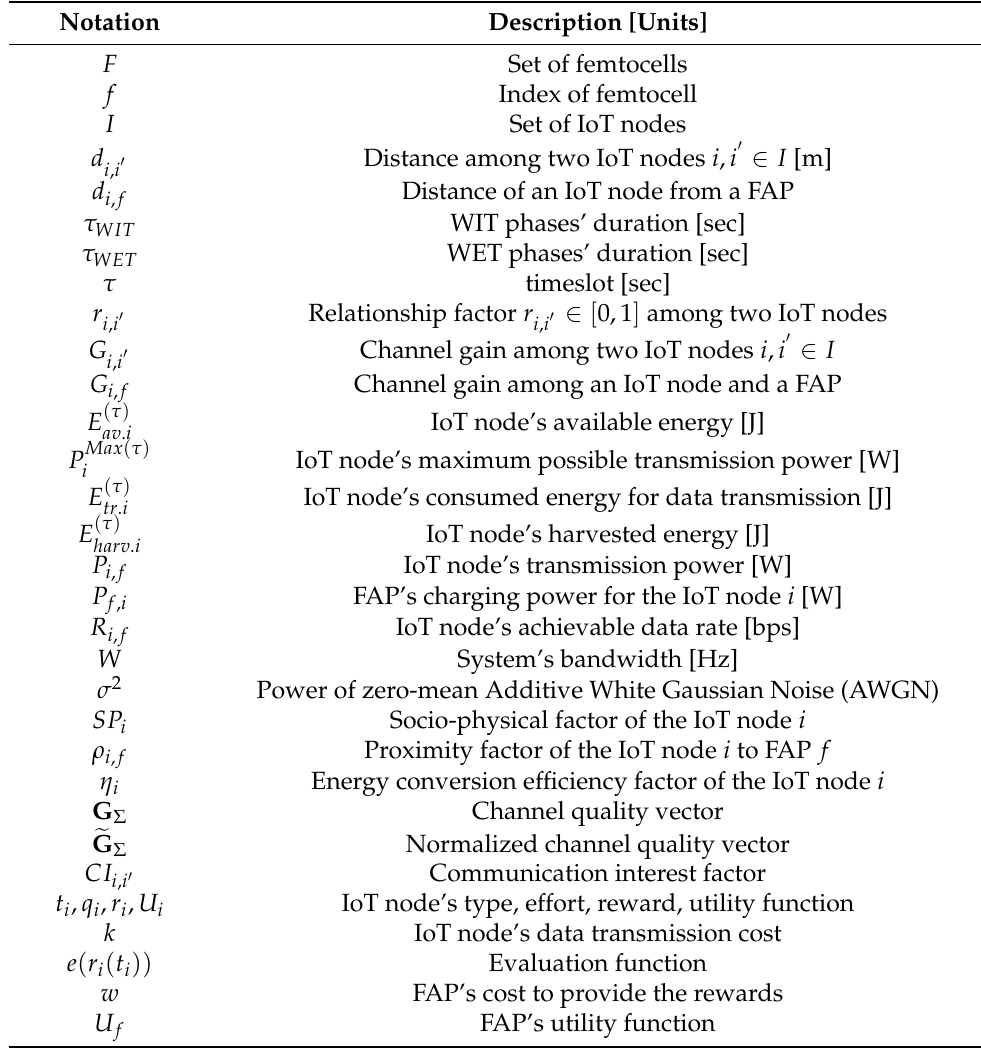
Table 2. Summary of Key